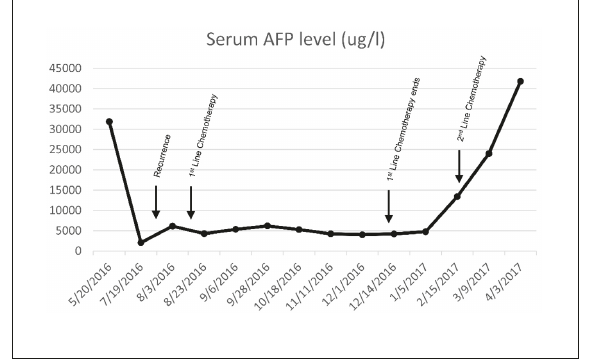
Figure 2: Serum AFP progression.